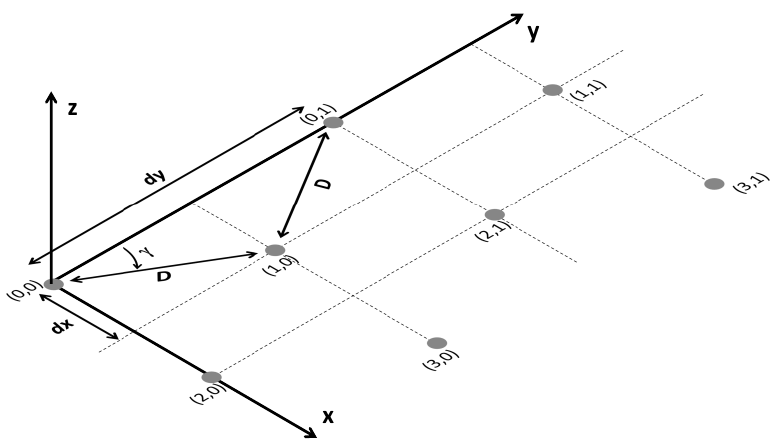
Figure 3. Planar antenna array with a triangular lattice.